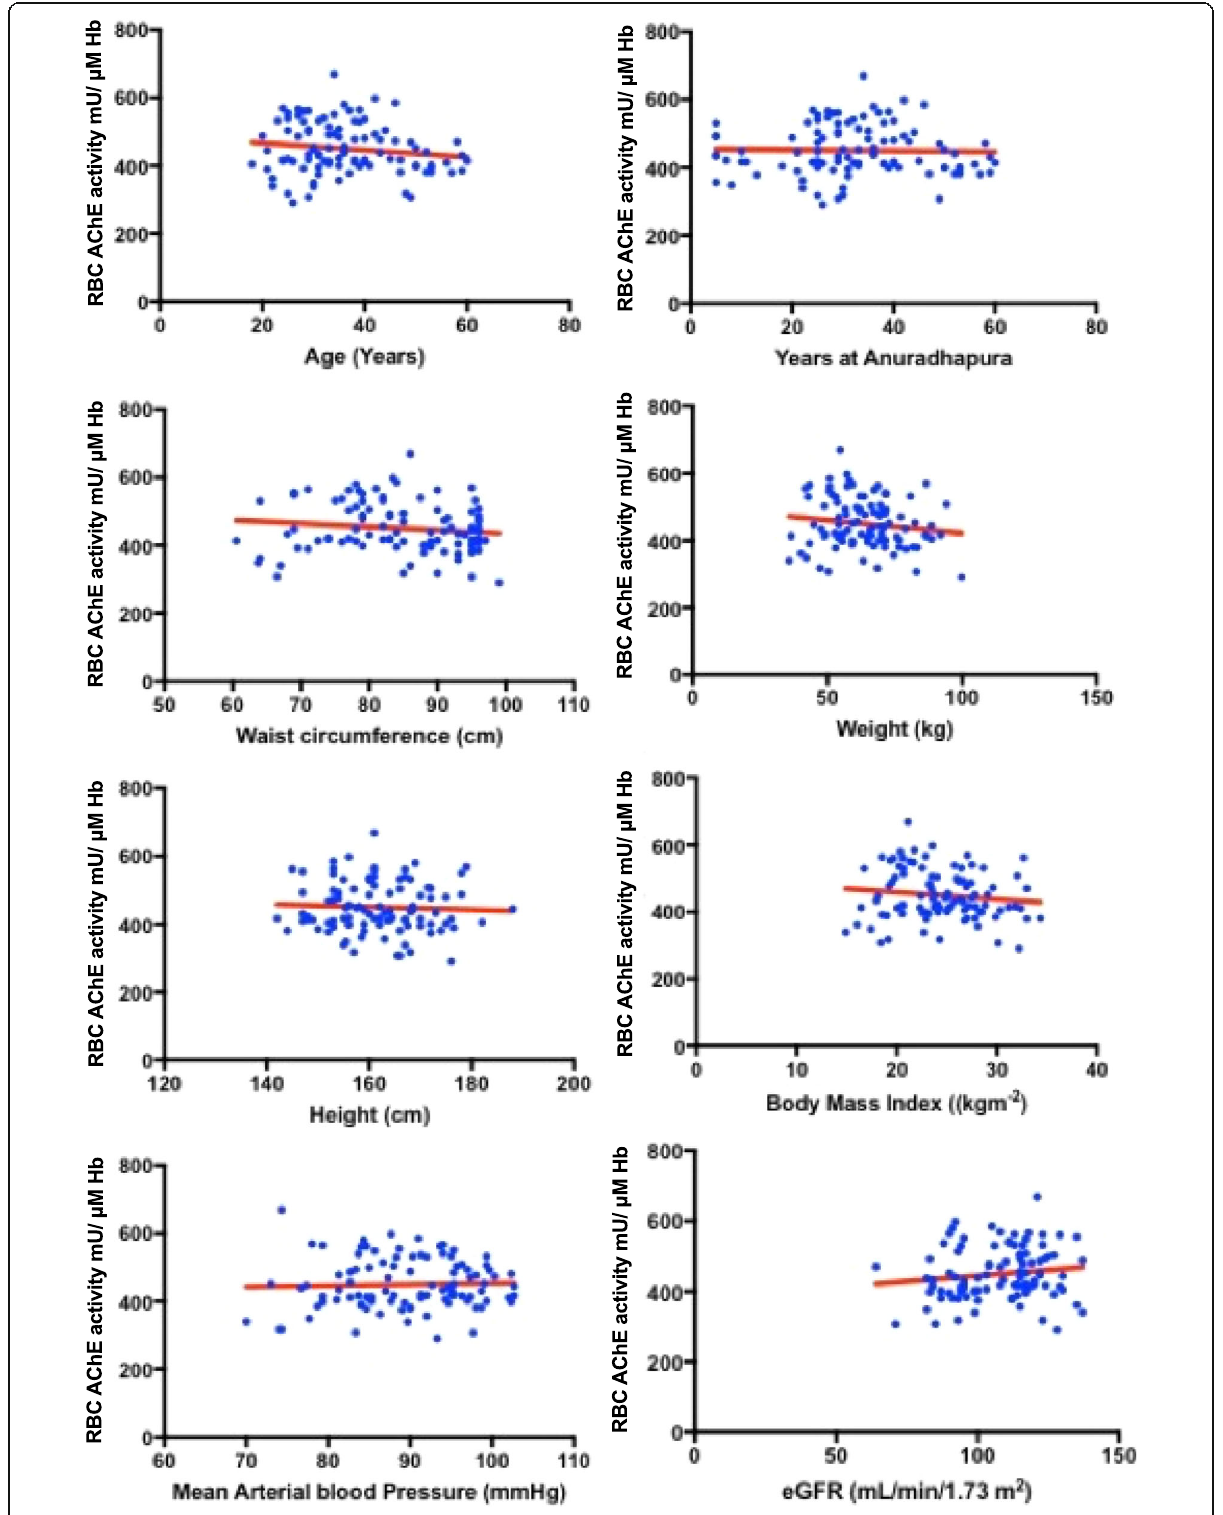
Fig. 3 Scatter plot for RBC-AChE activity against its possible determinants among healthy non-farmers of Anuradhapura,